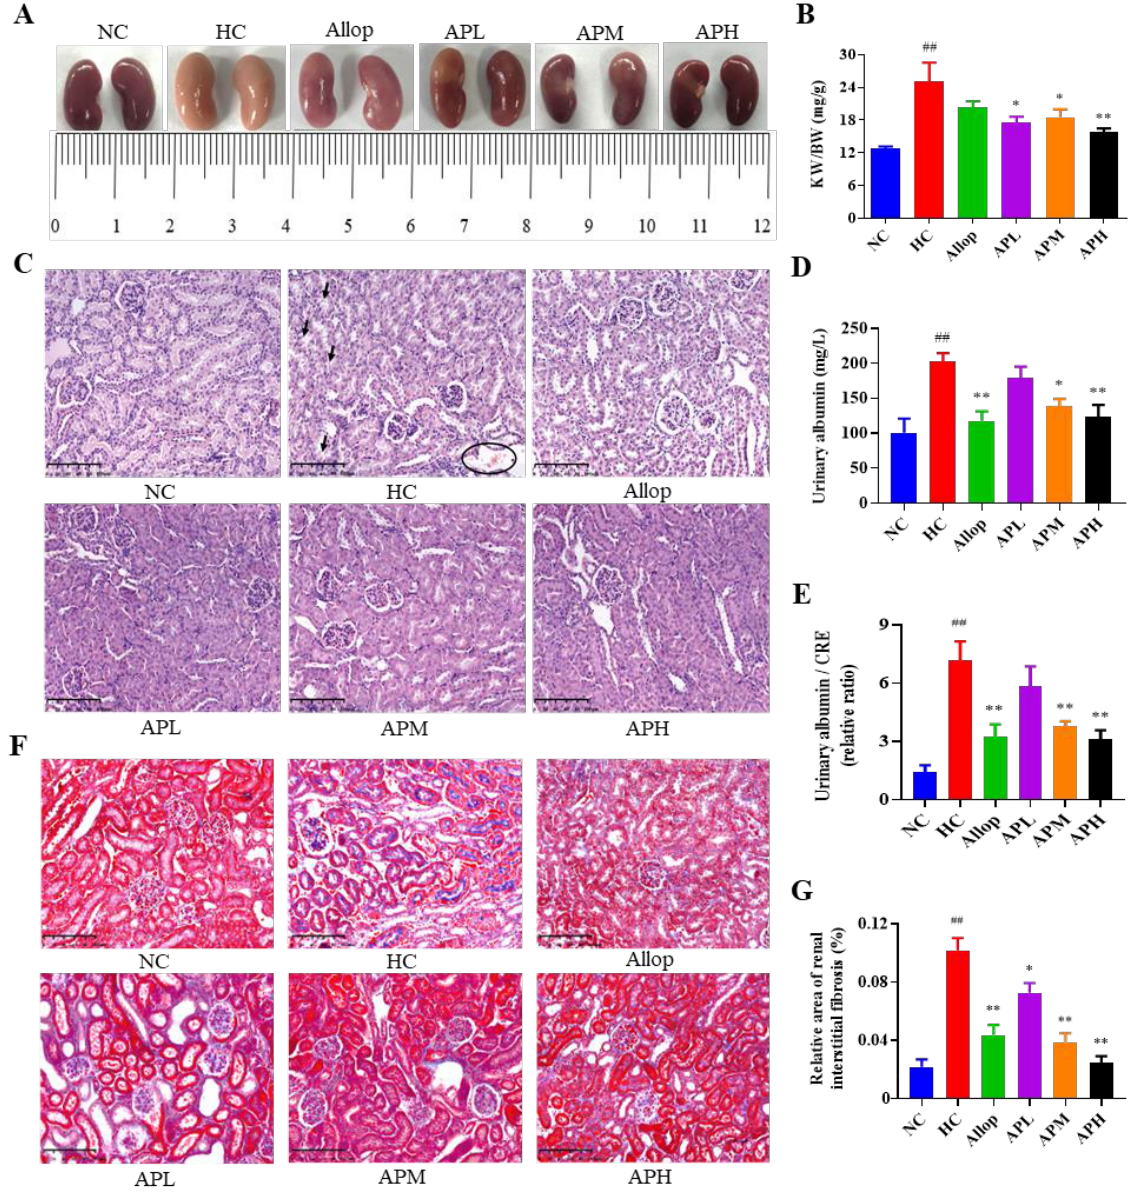
Figure 2. Apigenin ameliorates renal general appearance and pathological microstructures and urine protein levels in HUA mice. The histological appearance of the kidney ( A ). Kidney weight/body weight ( B ; KW/BW, mg/g, n = 10). Representative images of H&E staining ( C ; × 200, Scale bar: 100 µ m) of the kidneys. Urine albumin levels ( D ; mg/L, n = 8). The relative levels of urinary albumin to CRE ( E ; n = 6). The representative images of Masson trichome staining and their analyses ( F , G ; × 200, Scale bar: 100 µ m, n = 6). The black arrow indicates that the renal tubular epithelial cells were hollowed out, edema. The black circle indicates renal interstitial hemorrhage. The blue color denotes collagen fibers in the kidney. ## p < 0.01 vs. the NC group. ** p < 0.01, * p < 0.05 vs. the HC